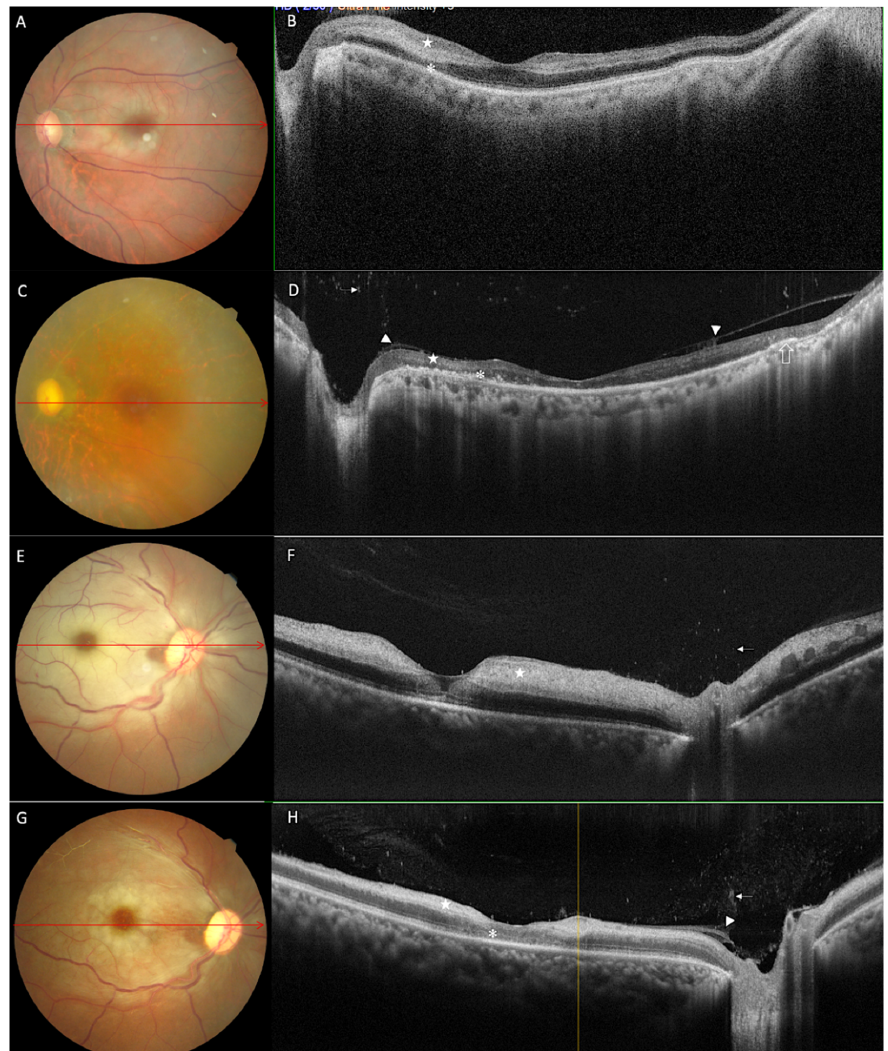
Figure 3. Serial fundus photographs and SD-OCT images of two representative cases: Case 10: At baseline, ( A ) fundus photographs show diffuse retinal whiting with a cherry red spot. ( B ) Mor- phological alterations on corresponding SD-OCT includes increased inner retinal thickness and hyperreflectivity (white star), focal disruption of ELM and photoreceptor layer with focal areas